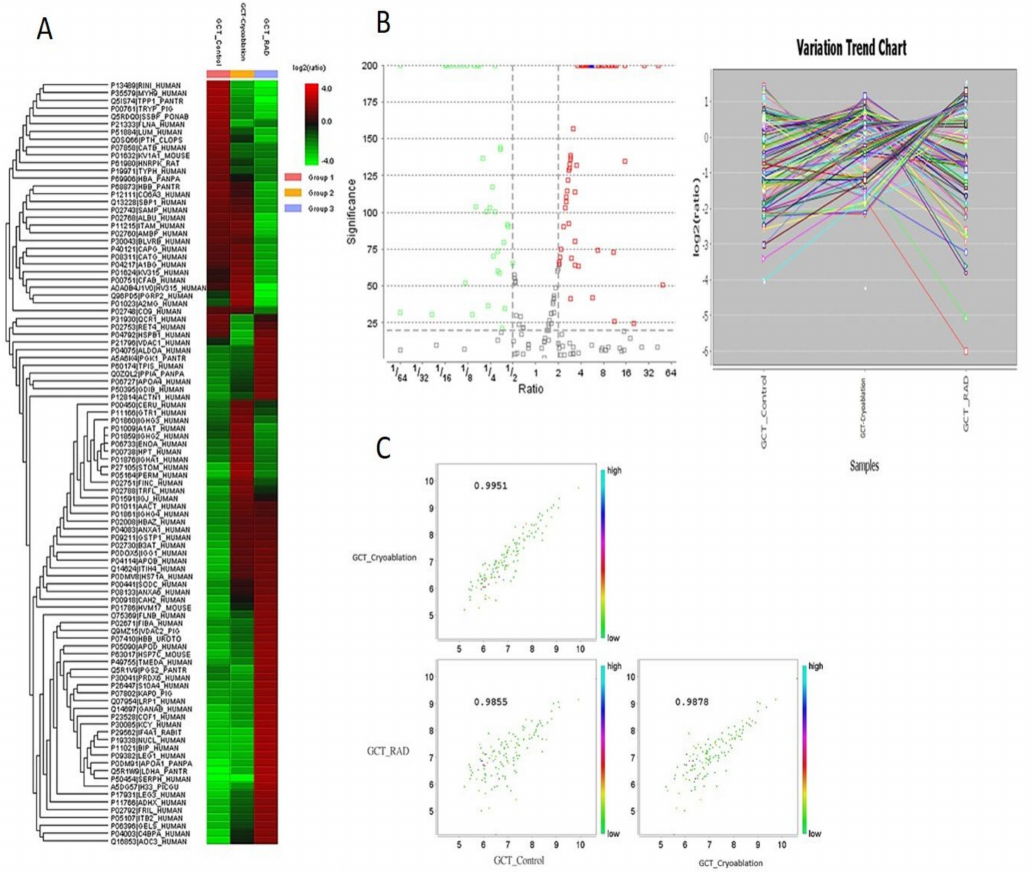
Figure 1. Label-free quantification analysis of 107 di ff erentially expressed proteins from comparative giant cell tumor of bone samples. ( A ) Heat maps were generated using Peaks X proteomic software that is showing various classes of protein expression profiles of giant cell tumors of bone (GCT) compared among untreated and cryoablation and irradiation treated. The log2 ratios of the abundance of each sample relative to the average abundance. ( B ) Volcano plot analysis showing the up-regulated proteins in red color and down-regulated proteins in green and the similarly expressed proteins in gray squares. ( C ) Identified proteins correlation among three groups for the protein names see Tables 1 and